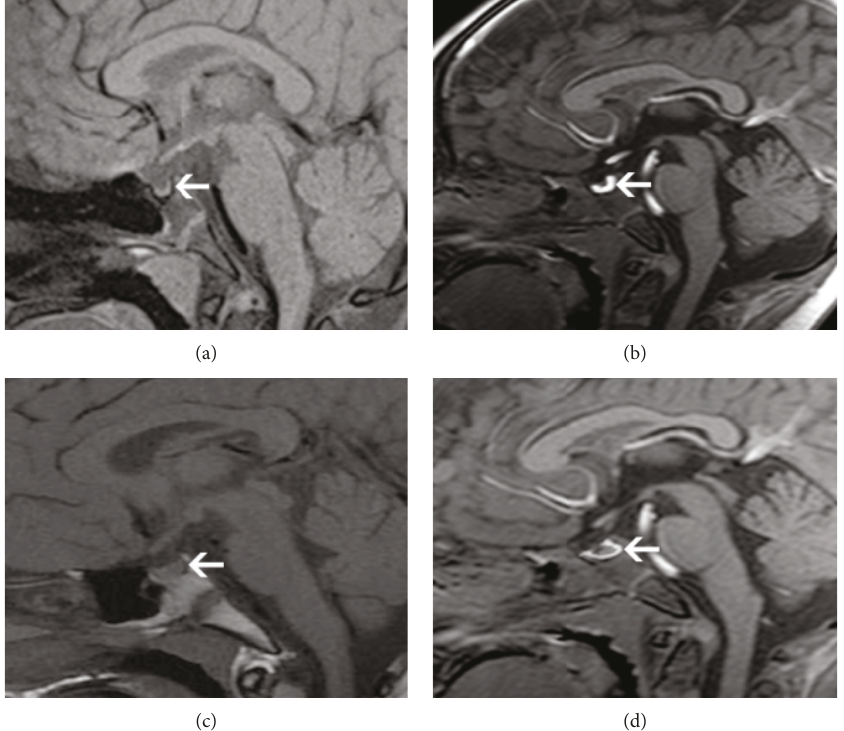
Figure 3: Pituitary stem blockage syndrome. (a) T1WI showed that the anterior pituitary was thin, the central site was sunken, the posterior pituitary high signal was not clearly shown, and the pituitary stalk was interrupted (white arrow). (b) The enhanced examination showed a small ectopic position in the anterior pituitary and after the optic chiasm, and obvious uniform enhancement was found in the posterior leaves. (c) T1WI showed that high intensity of posterior pituitary was disappeared and the pituitary stalk showed a thin line. (d) The enhanced examination showed anterior pituitary atrophy.